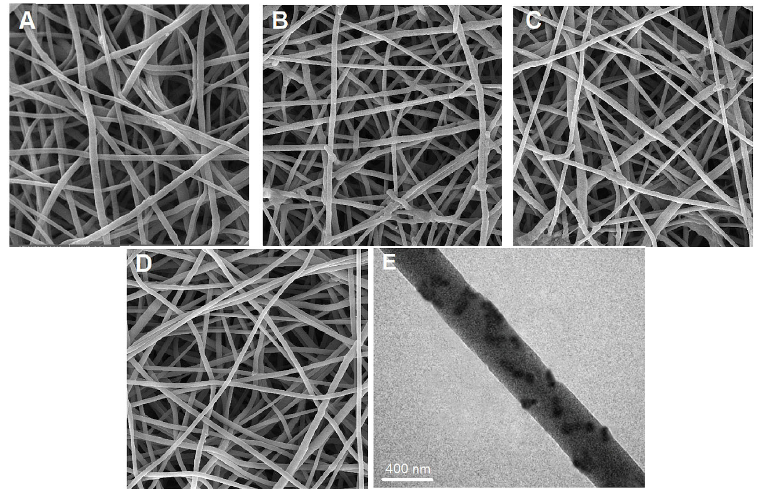
Figure 7. Morphology of electrospun NFs. FE-SEM images of: ( A ) neat PLGA NFs; ( B ) MSNs/PLGA NFs; ( C ) CUR/PLGA NFs; ( D ) CUR@MSNs/PLGA NFs. ( E ) TEM image of CUR@MSNs/PLGA NFs. Reprinted/adapted with permission from Ref. [65]. 2021,